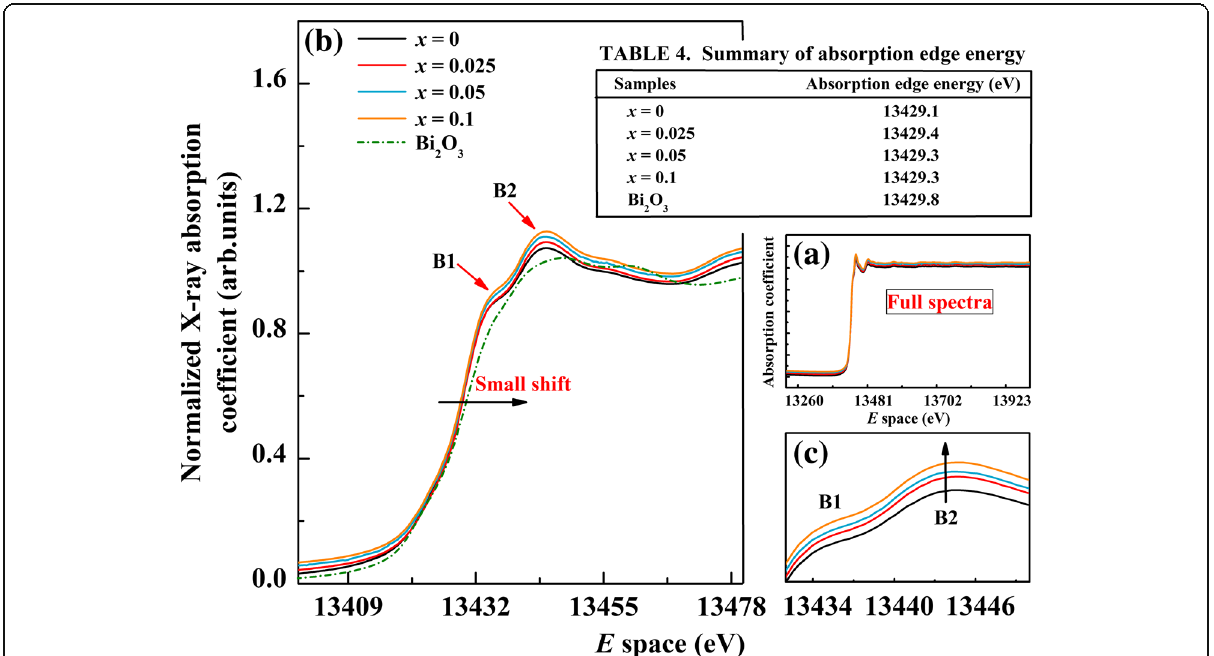
Fig. 5 a Bi L 3 -edge XANES spectra of BFA x O (0 ≤ x ≤ 0.1) and reference Bi 2 O 3 . b XANES spectrum in the range of 13,400 – 13,480 eV. c Enlarged view of the peak D and peak